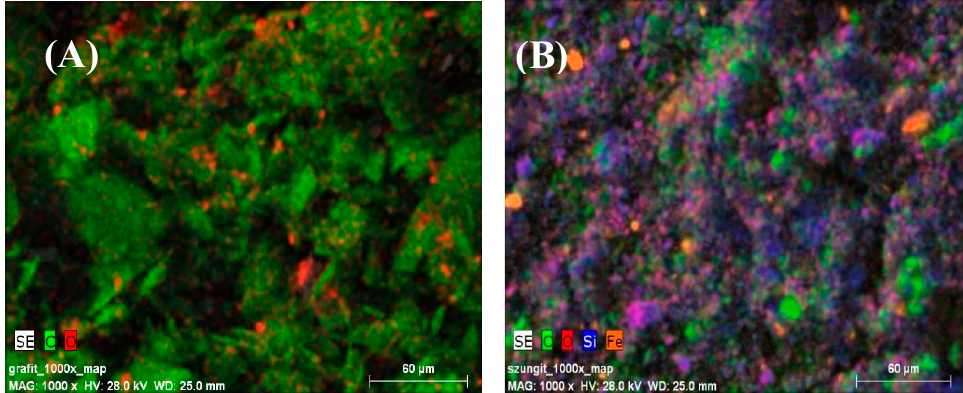
Figure 3. SEM-EDX images of ( A ) graphite and ( B ) shungite.